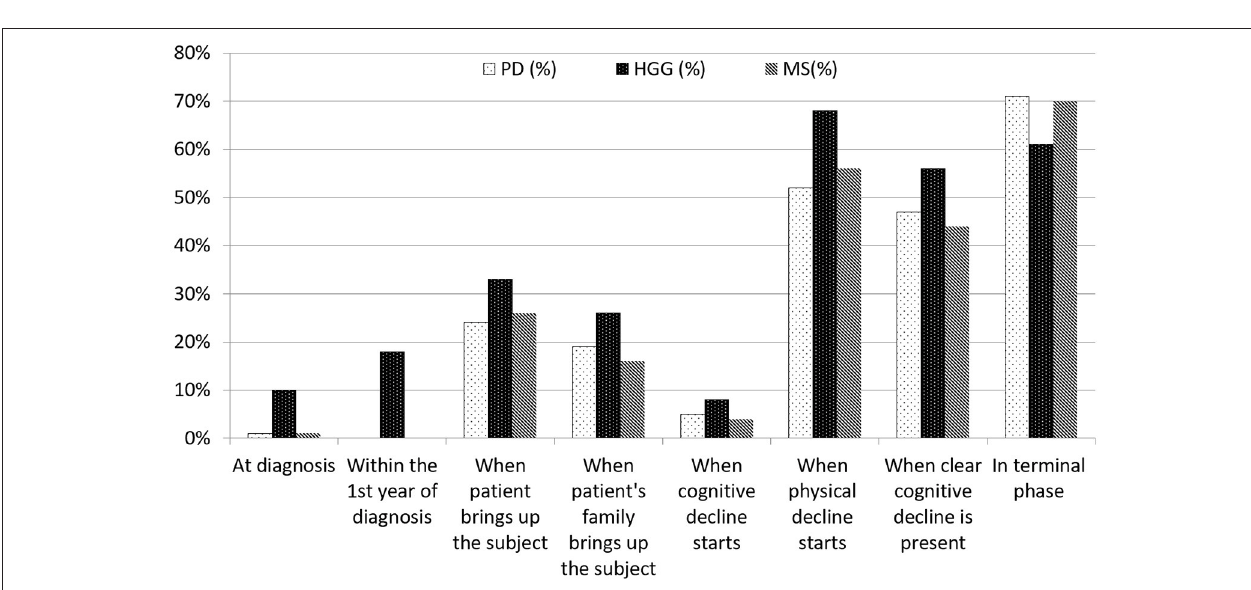
FIGURE 2 | Timing of discussions on treatment restrictions by consultants in neurology and residents. There was no definition provided regarding ‘when cognitive decline starts’. ‘When clear cognitive decline is present’ was defined as ‘incapacitating tha patient to (fully) understand and take part in